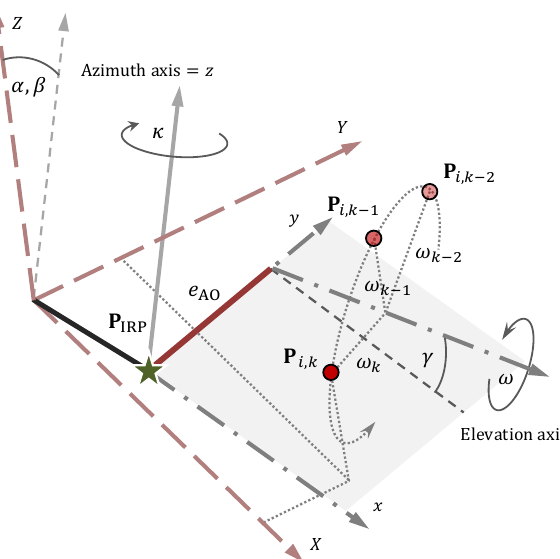
Figure 2. Invariant reference point (IRP) transformation model that combines the grey dash-dotted depicted telescope fixed frame and the light red dashed depicted Earth-fixed reference frame. An arbitrary marker p i is shown in several k telescope orientations. The green star marks the reference point P IRP